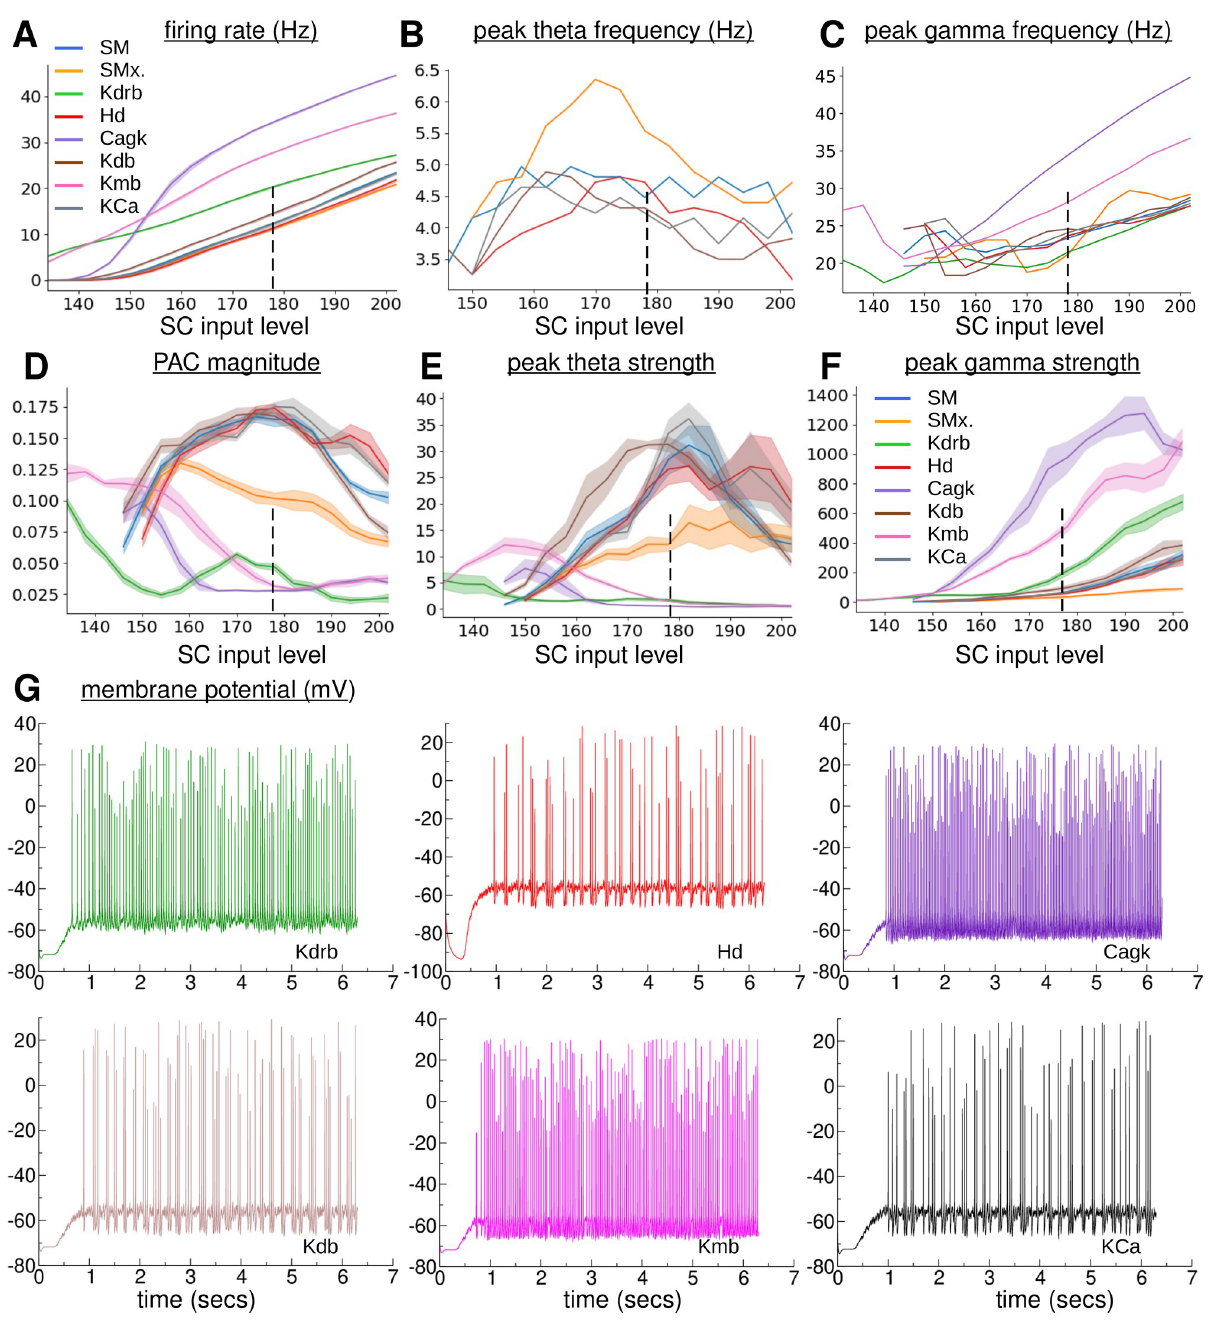
Fig 7. Dependence of TSGPAC on SCIL in the 120 PYR, 10 OLM SM model with OLM ion channel knock-out. Blue: unmodified SM model. Orange: unmodified SMx model with OLM-PYR connections removed. Green: SM model with OLM K DR knock-out. Red: SM model with OLM I h knock-out. Purple: SM model with OLM Cagk knock-out. Brown: SM model with OLM K D knock-out. Pink: SM model with OLM K M knock-out. Grey: SM model with OLM K Ca knock-out . (A) OLM firing rates . (B) OLM population peak theta frequency. Location of power spectrum peak in 1-8 Hz band . C OLM population peak gamma frequency. Location of power spectrum peak in 15-50 Hz band . (D) OLM population total PAC magnitude in the theta, 1-12 Hz, band and slow-gamma, 12-50 Hz, band . (E) OLM population theta strength. Theta band power spectrum peak size . (F) OLM population gamma strength. Gamma band power spectrum peak size . (G) Exemplar membrane potential traces from a cell in the simulations at SCIL 178, indicated by the dashed vertical line in (a-f), (see labels.) (A,D-F) Shaded bands show SEM in the plotted values across two simulations with random configurations. SEM not shown in (b,c) for clarity .